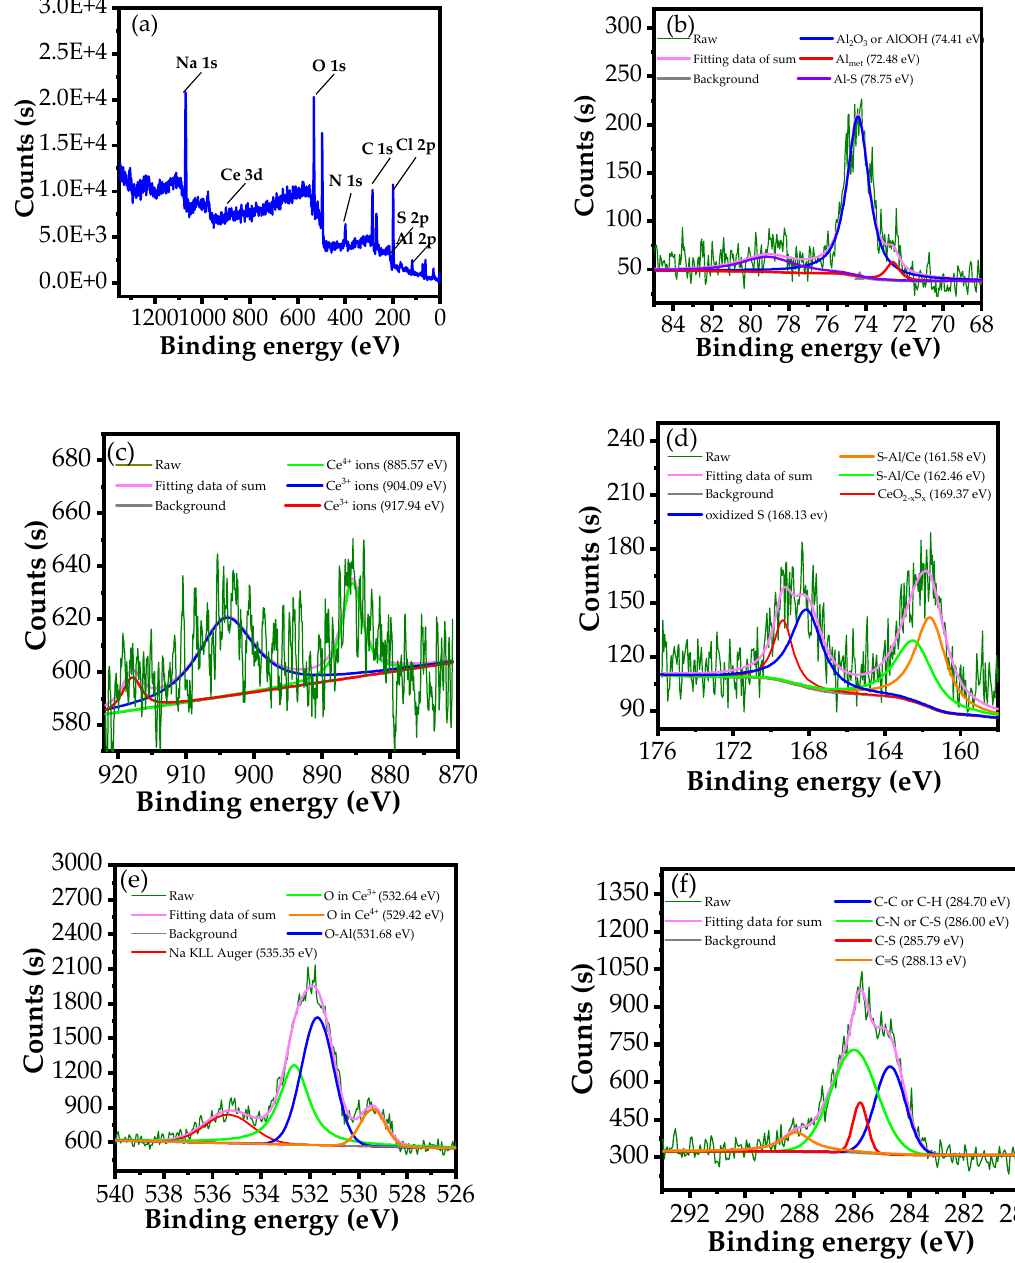
Figure 10. ( a ) XPS survey scan of AA 2024-T3 alloy surface immersed in a 3.5% NaCl-containing inhibitor. High-resolution scans of ( b ) Al 2p, ( c ) Ce 3d, ( d ) S 2p, ( e ) O 1s, and ( f ) C 1s. Table 4. Species present in the surface film of the test sample and their atomic percentages.